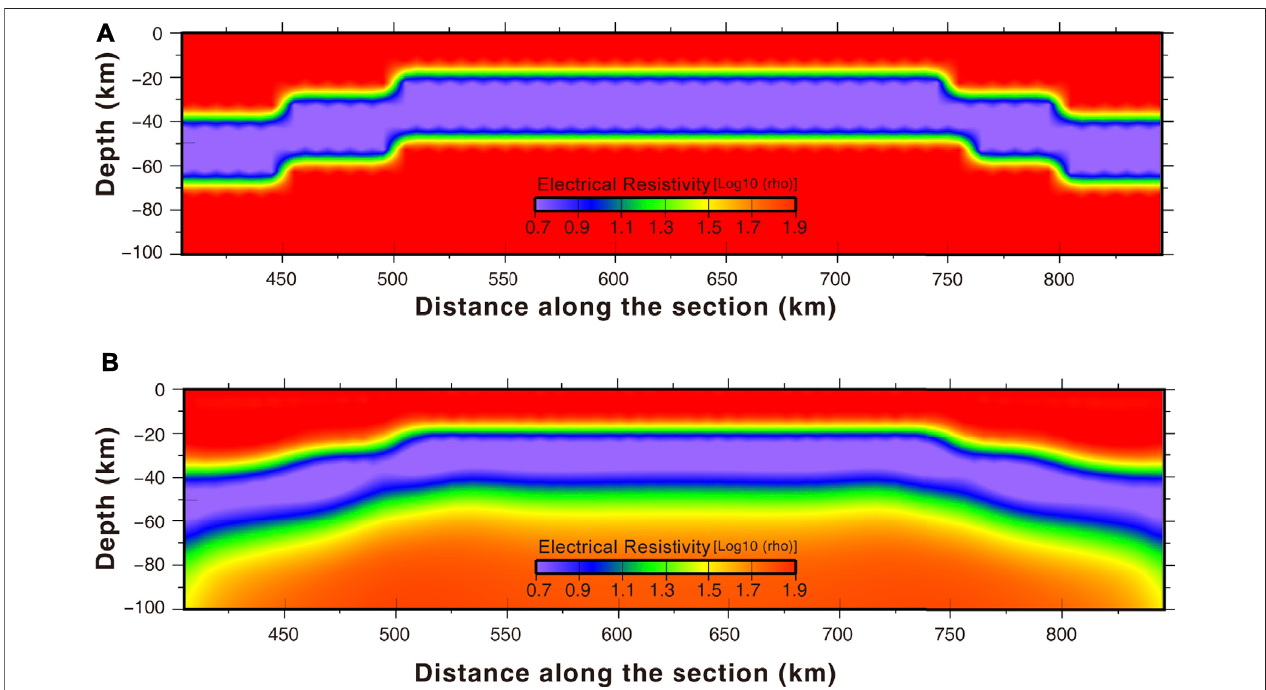
FIGURE 5 | Theoretical model of high-conductivity strip: (A) True Model and (B) Inversion result.